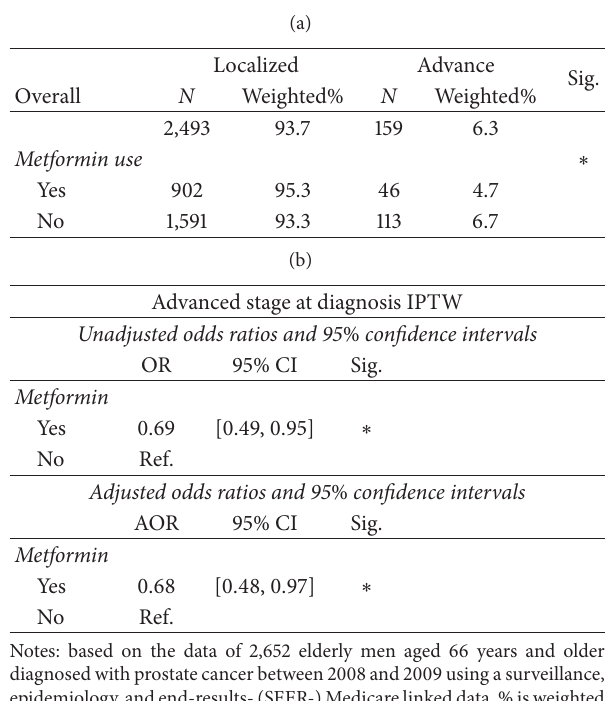
Table 3: (a) Number and IPTW-adjusted percentage of men with localized versus advanced stage of prostate cancer by metformin use among elderly Medicare beneficiaries with diabetes and incident prostate cancer surveillance, epidemiology, and end-results- (SEER- ) Medicare linked database, 2007–2010. (b) Unadjusted and adjusted odds ratios and 95% confidence intervals from (IPTW) logistic regressions for advanced stage at diagnosis of